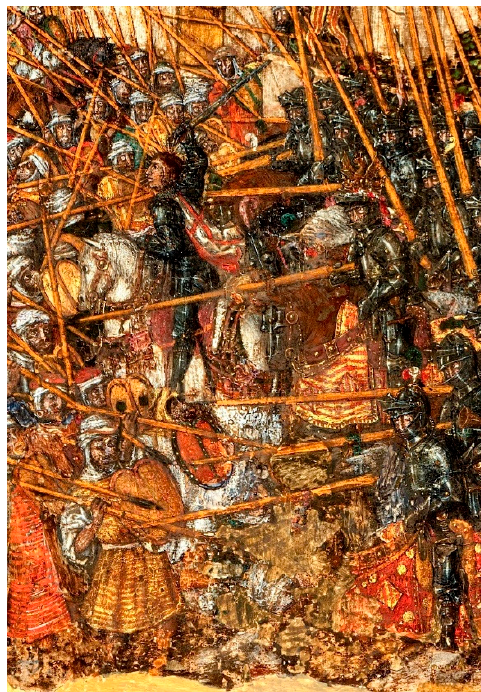
Figure 39. St George and King James I conquering the city of Majorca, Pere Niçard, and Rafel Moger, Altarpiece of St George, predella, Majorca, 1450–1468. Museu Diocesà de Mallorca Museu d’Art Sacre